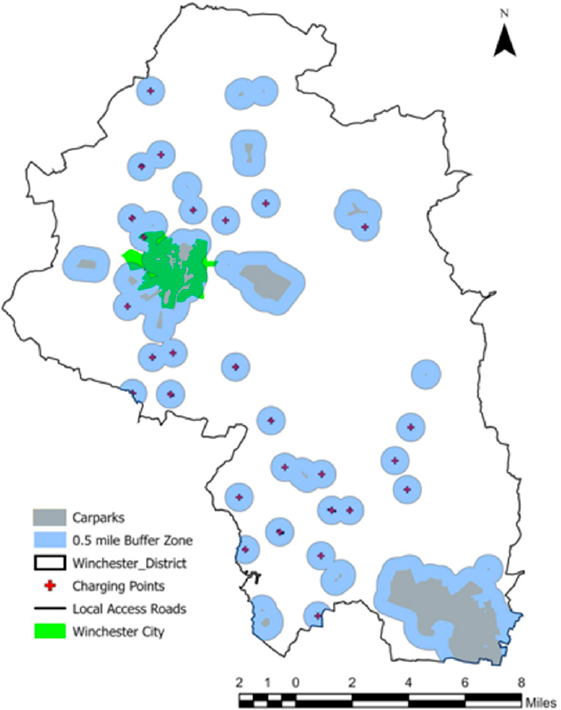
Figure 8. Revised siting of 28 on-road EV charging points for Winchester District.